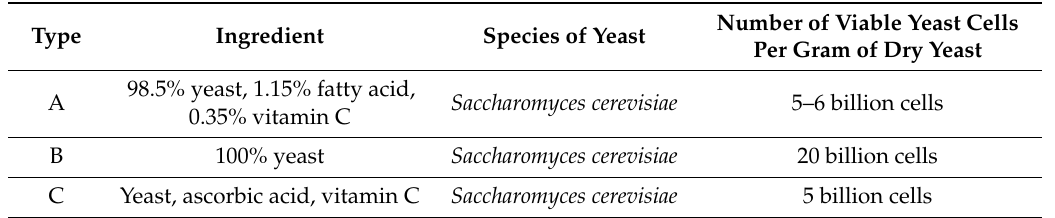
Table 4. Types of dry yeast for each